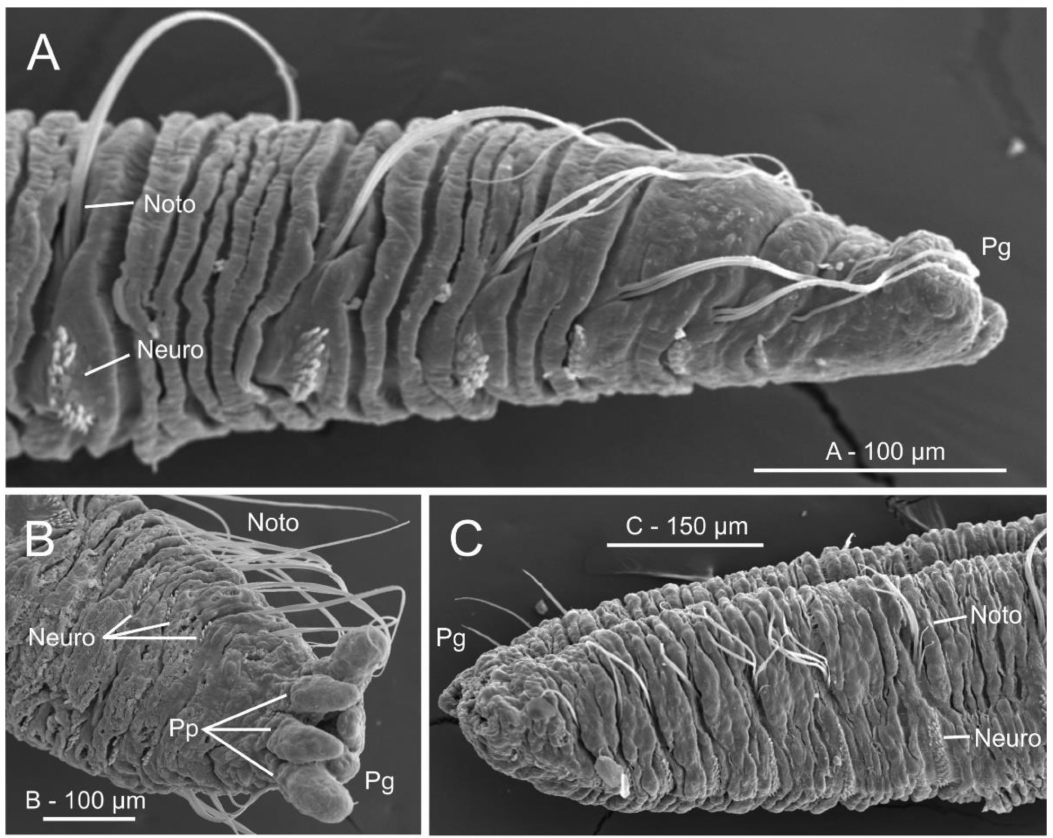
Figure 17. SEM micrographs of posterior end of ( A ) Galathowenia oculata ; ( B ) G. fragilis ; ( C ) Myriochele heeri . ( B , C ) modified from [68]. Abbreviations: Neuro—neuropodium, Noto—notopodium, Pg—pygidium, Pp—pygidial